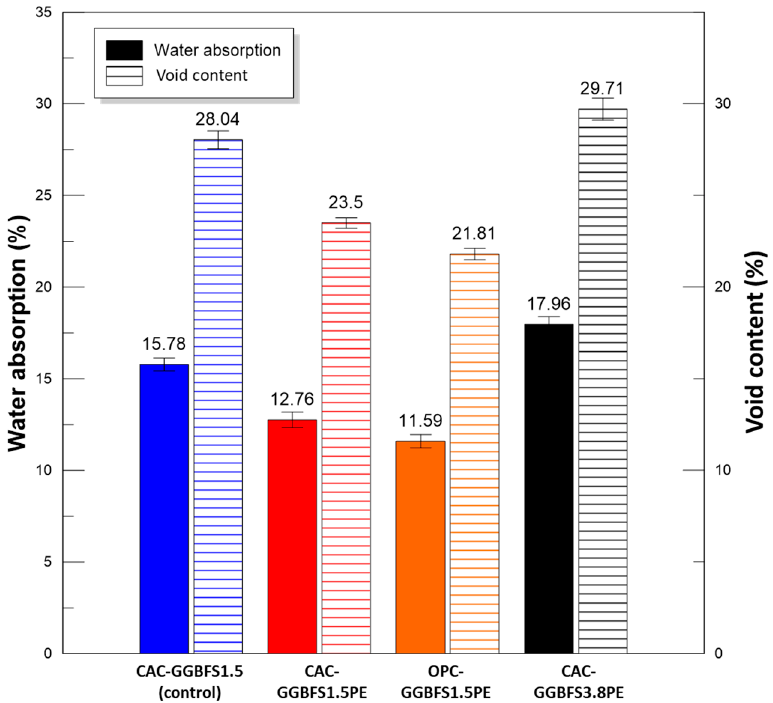
Figure 6. Water absorption and void content (average values).